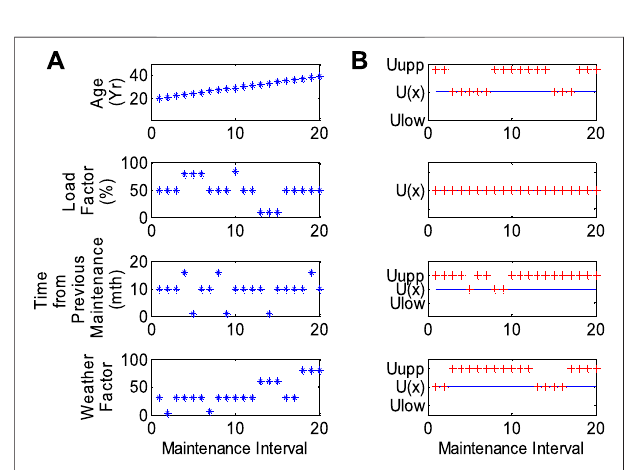
FIGURE 9 | Varying operation conditions of transformers: (A) operation variations; (B) secondary uncertainty of each operation variation.